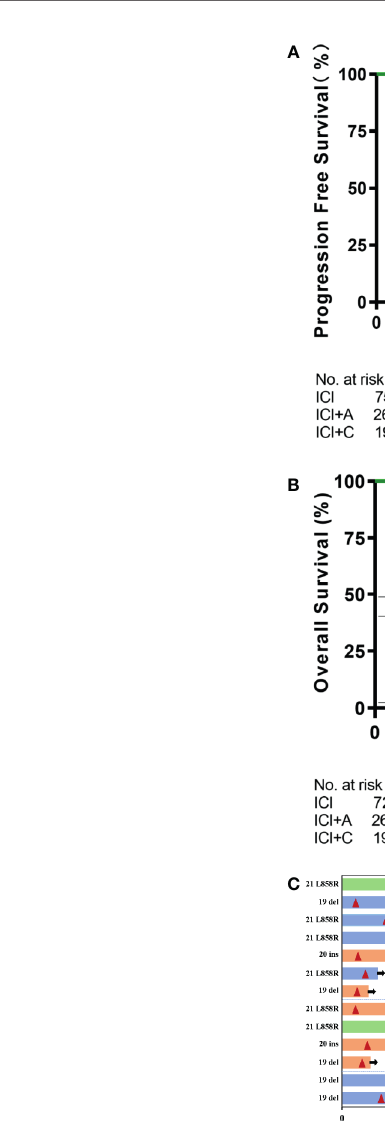
FIGURE 1 | The progression-free survival and overall survival of patients treated with three immune checkpoint inhibitor-based strategies. Kaplan – Meier estimates of the progression-free survival (A) and overall survival (B) of patients treated with ICI monotherapy (green), ICI plus an anti-angiogenic agent (blue), and ICI plus chemotherapy (orange). Censored data are indicated by ticks. In the analysis of progression-free survival, data from patients who had not progressed and were still alive at the time of analysis were censored at their last assessment. In the analysis of overall survival, data from patients who were considered to be alive at the time of analysis were censored at the last recorded date on which the patients were known to be alive. (C) A swimmer plot summarizing the responsiveness of thirteen patients with EGFR mutations. CI, con fi dence interval; HR, hazard ratio; ICI, immune checkpoint inhibitor; A, anti-angiogenic therapy; C, chemotherapy; PR, partial response; SD, stable disease; PD, progressive